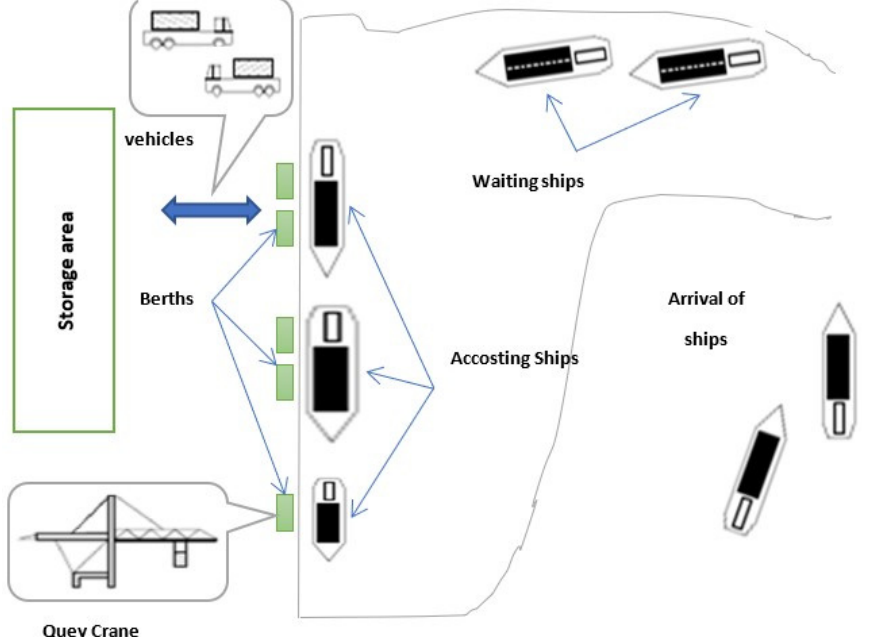
Figure 1. Graphical illustration of the process of berthing of ships.